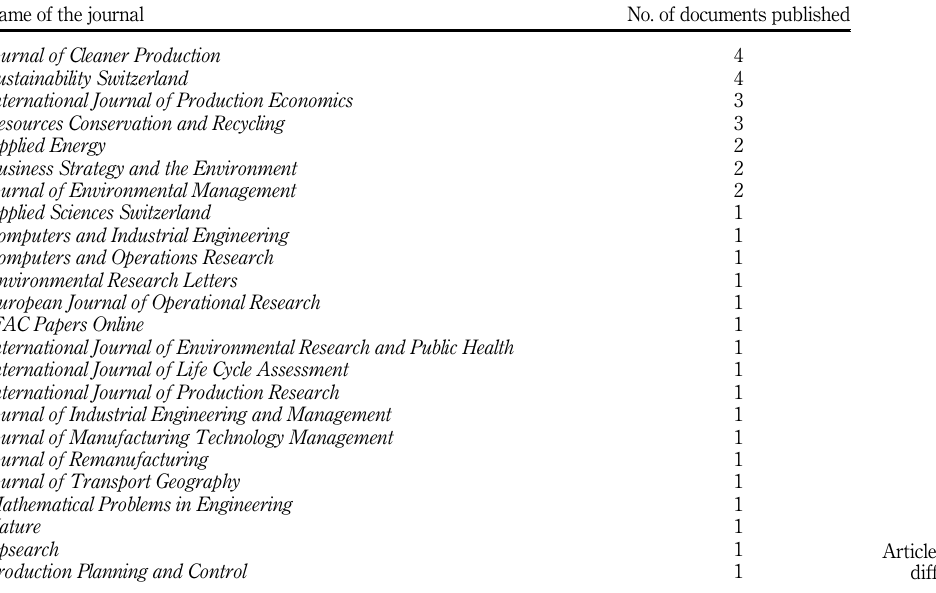
Table 3. Articles published